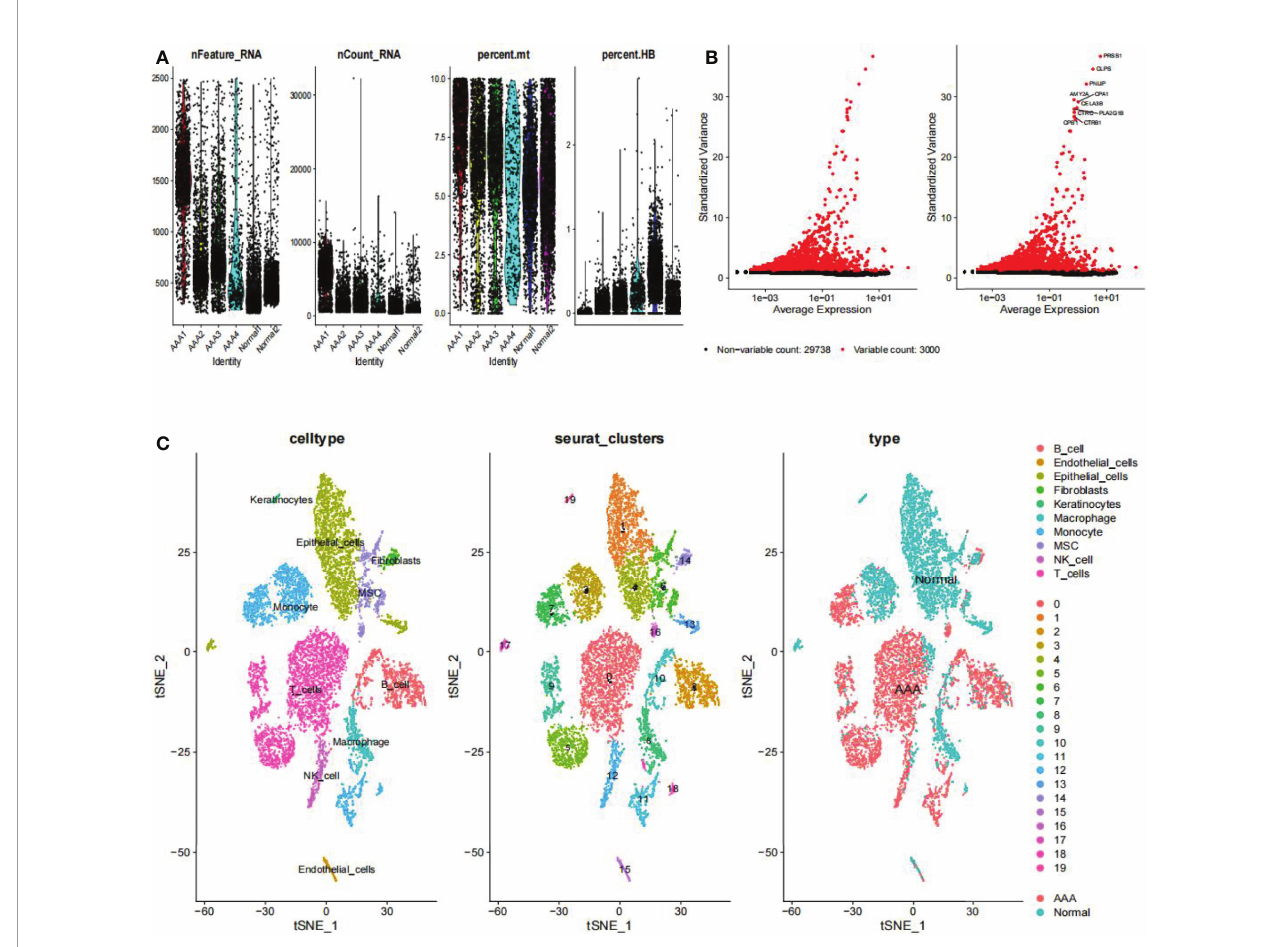
FIGURE 2 | Clustering of GSE166676 single cells for quality control and dimension reduction. (A) The proportion of mitochondrial and erythrocyte genes is adjusted to ensure the quality of cell samples. (B) 3,000 highly variable genes are indicated in red, with the 10 most important emphasized. (C) Reduced dimensionality and cluster analysis. The AAA dataset cells may be classi fi ed into 20 clusters, which include B cells, endothelial cells, fi broblasts, keratinocytes, macrophages, monocytes, mesenchymal stem (MSC), natural killer (NK) cells, and T cells. AAA, abdominal aortic